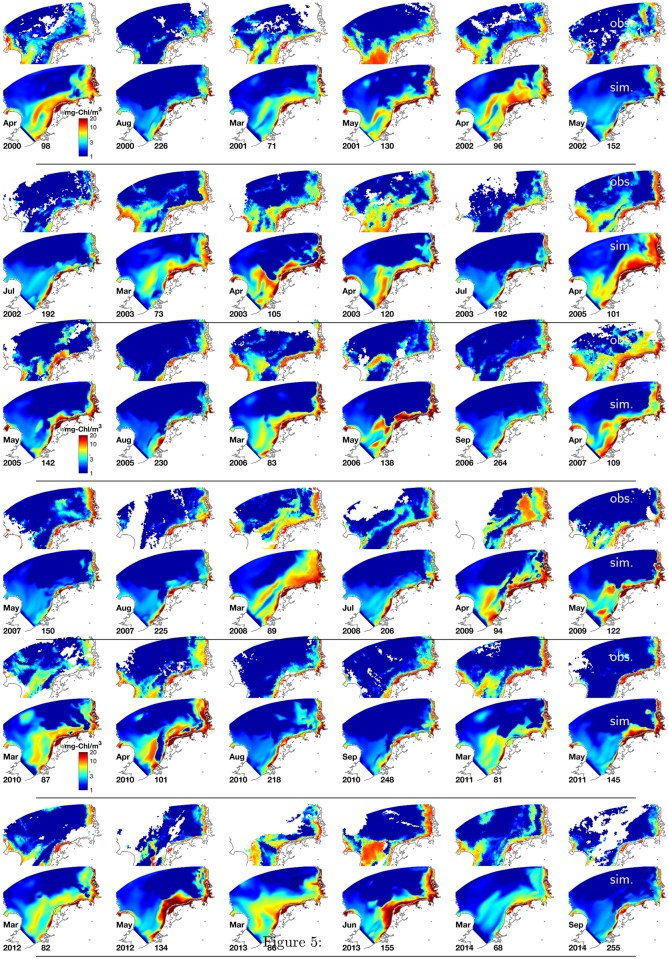
Snapshots of surface CHL from 2000 to 2014 at different Julian days in the southern North Sea, simulated (even rows) and observed (ESACCI, odd rows).